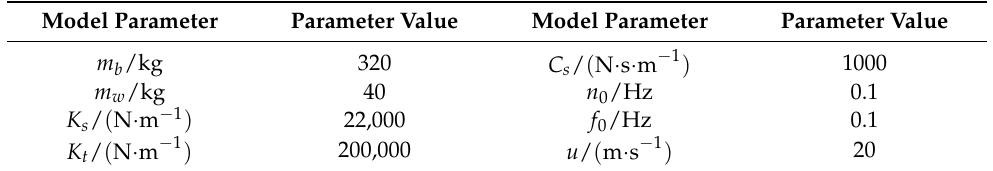
Table 1. Vehicle model parameters.